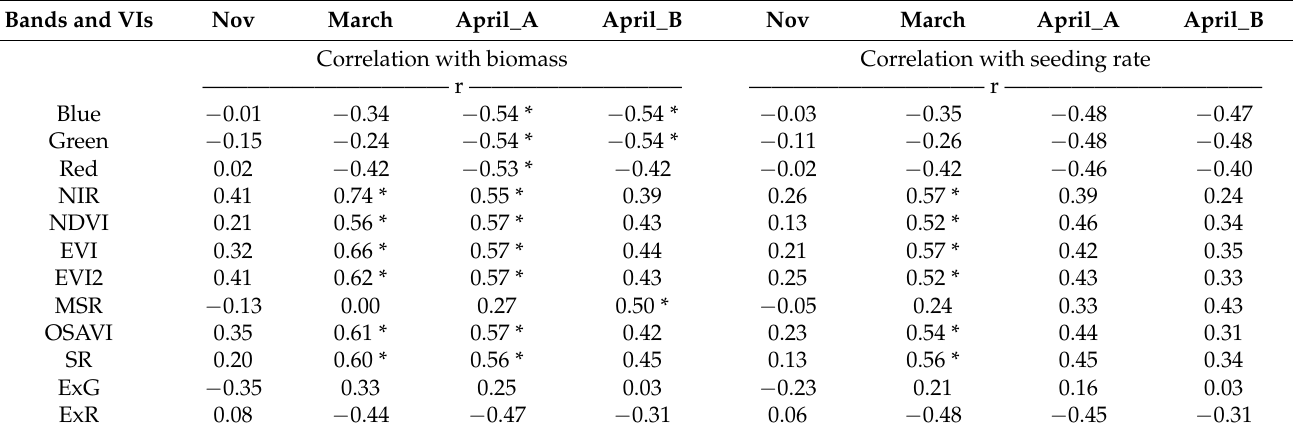
Figure 3. Cover crop seeding rate and pure live seed effect on biomass (across all four studies and cover crop species/mix for both year 2021 and 2022): ( A ) biomass yield and seeding rate linear relationship; ( B ) biomass return per kilogram of seeds; ( C ) biomass and pure live seeds linear relationship; and ( D ) biomass return per square meter of pure live seeds. Least square mean (individual points on the figure) of each treatment was used to plot the relationship and trends. Table 3. Pearson correlation coefficients of PlanetScope bands and vegetation indices (VI) during November (Nov), March, and April (April_A = 1–15 April; April_B = 15–30 April) with cover crop biomass and seeding